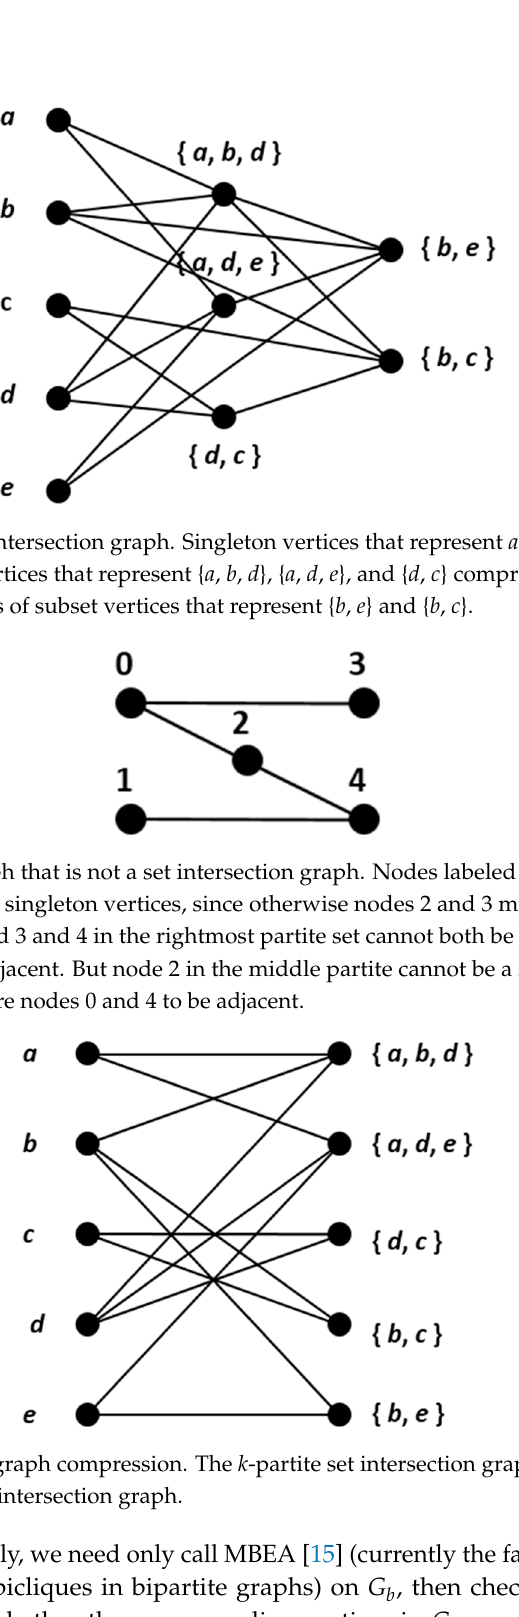
Figure 8. An example of graph compression. The k -partite set intersection graph of Figure 6 has been reduced to a bipartite set intersection graph.